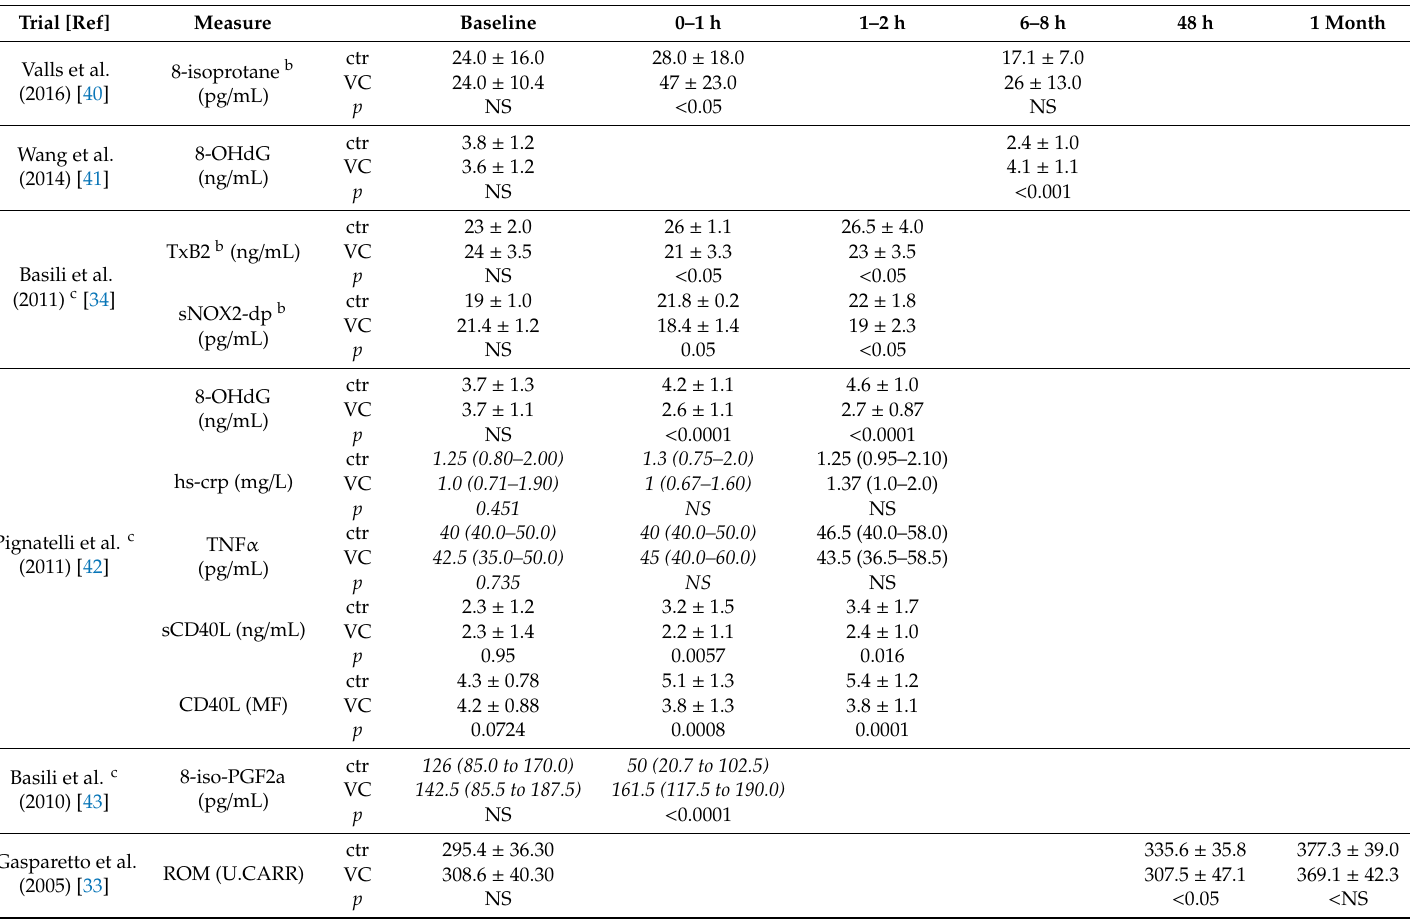
Table 4. E ff ect of Vitamin C on ROS and Inflammatory